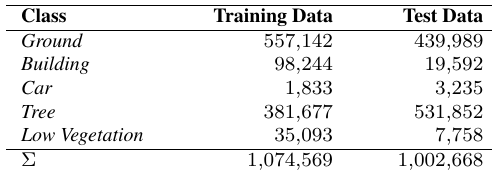
Table 2. Number of 3D points per class for the GML Dataset A . Note that the reference labels are provided for both the training data and the test